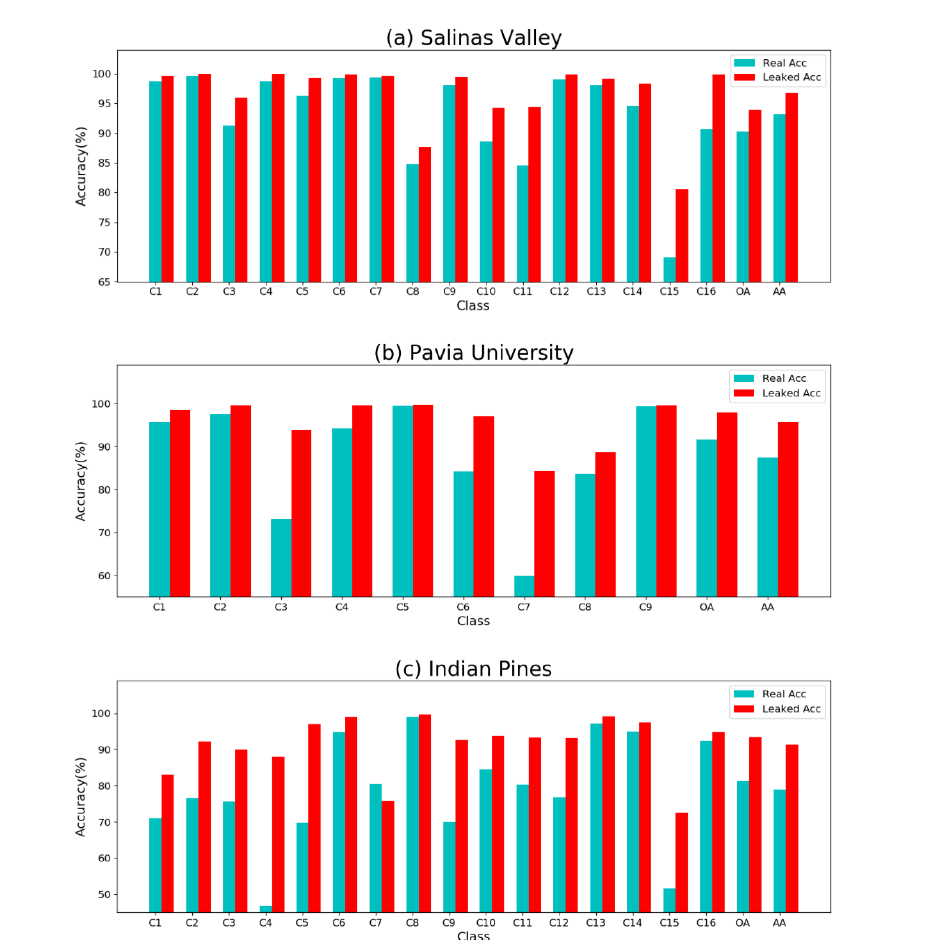
Figure 12. Classification results on none-leaked and leaked datasets for ( a ) Salinas Valley, ( b ) Pavia University, and ( c ) Indian